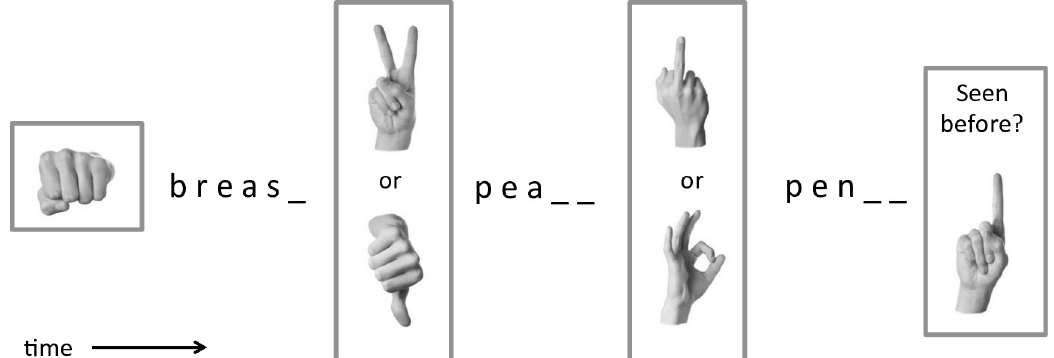
Fig 1. Visual summary of procedure. Images of manual gestures were followed by word-stem completion trials, in which words related to preceding gestures or did not.